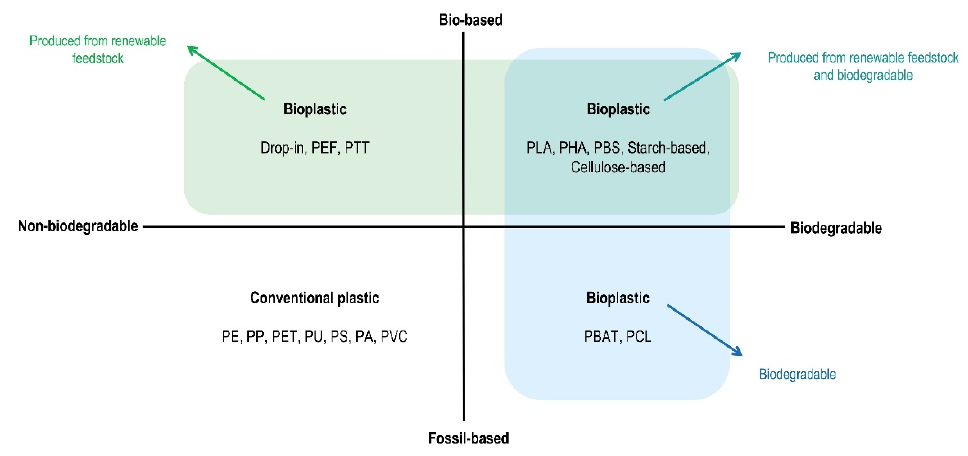
Figure 2. Plastic material categorized system (adapted from European Bioplastics [23]).